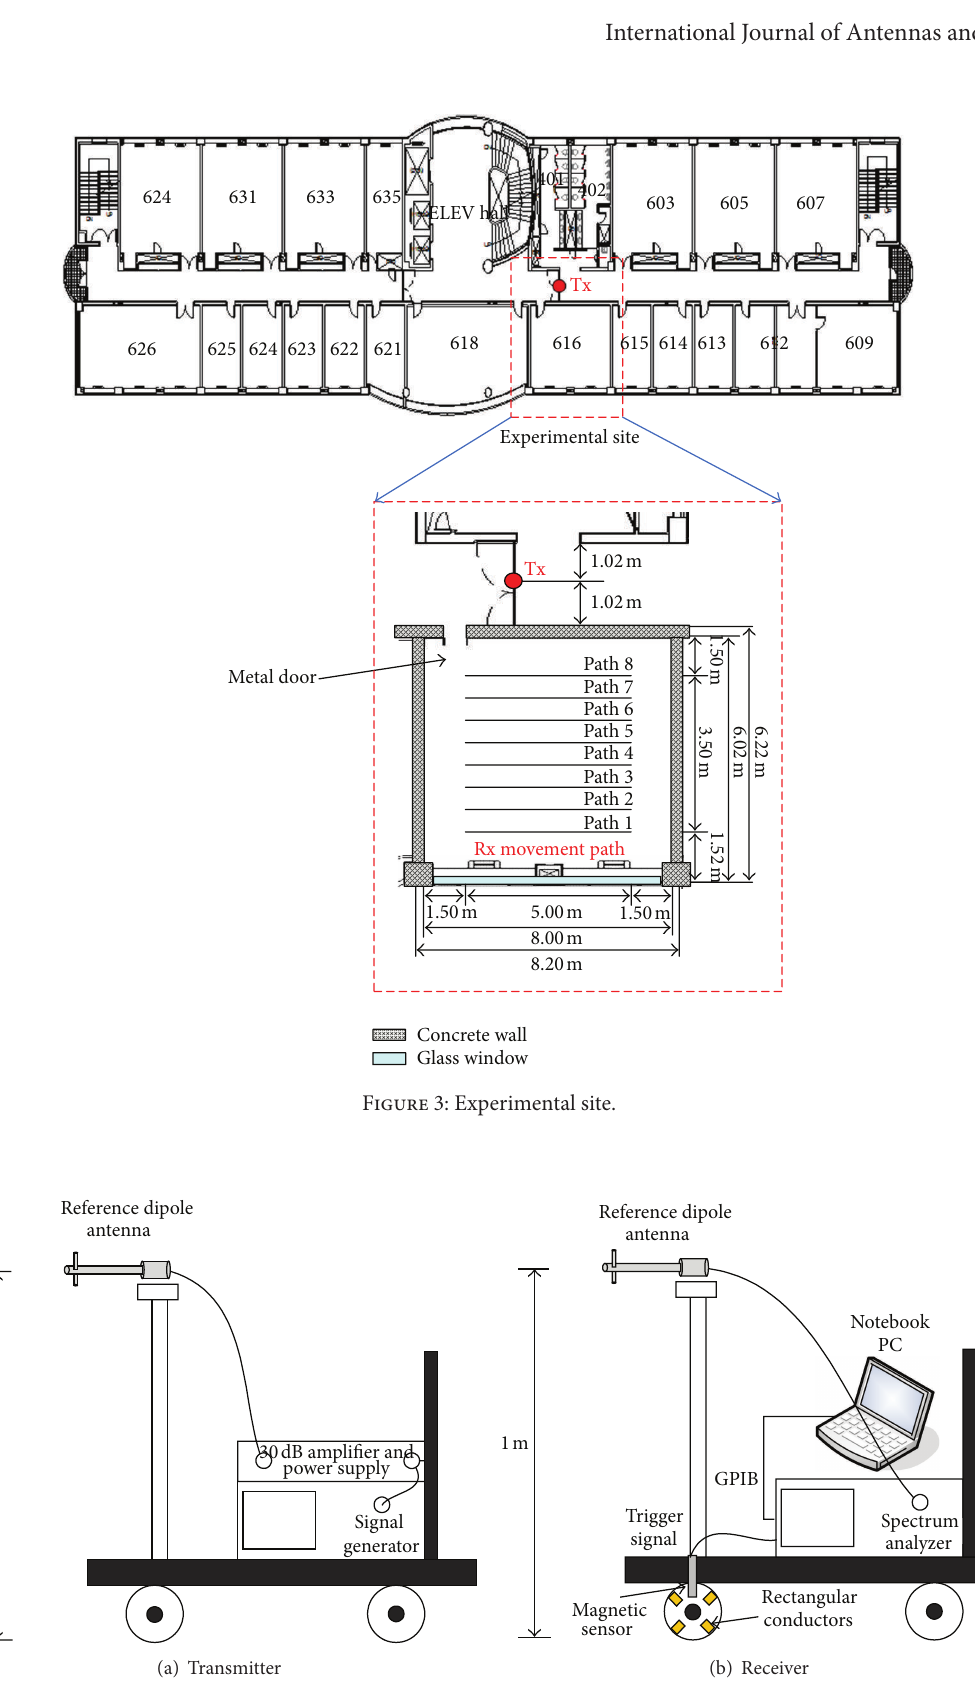
Figure 4: Measurement